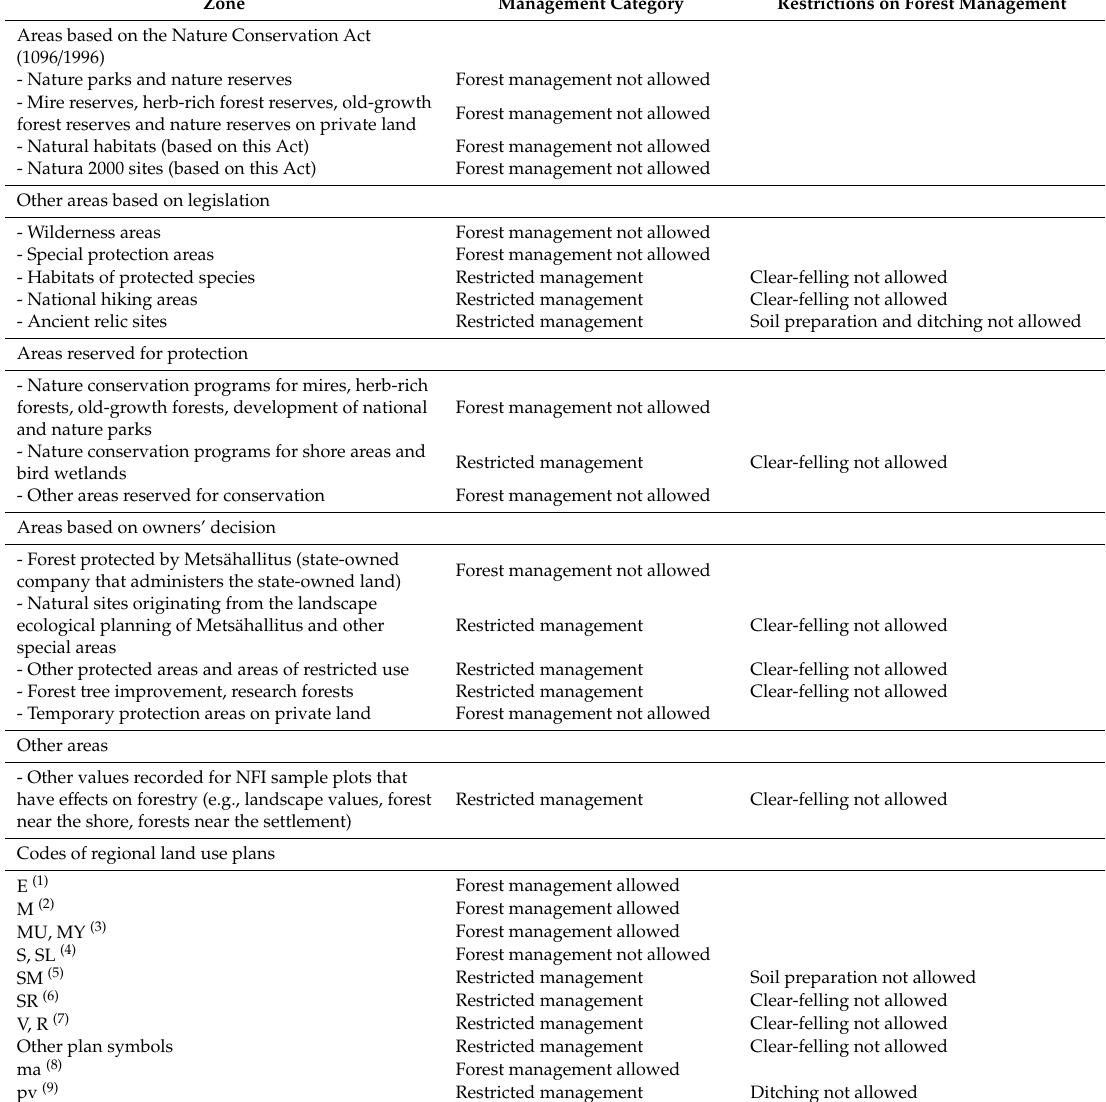
Table 2. Restrictions on forest management applied in di ff erent